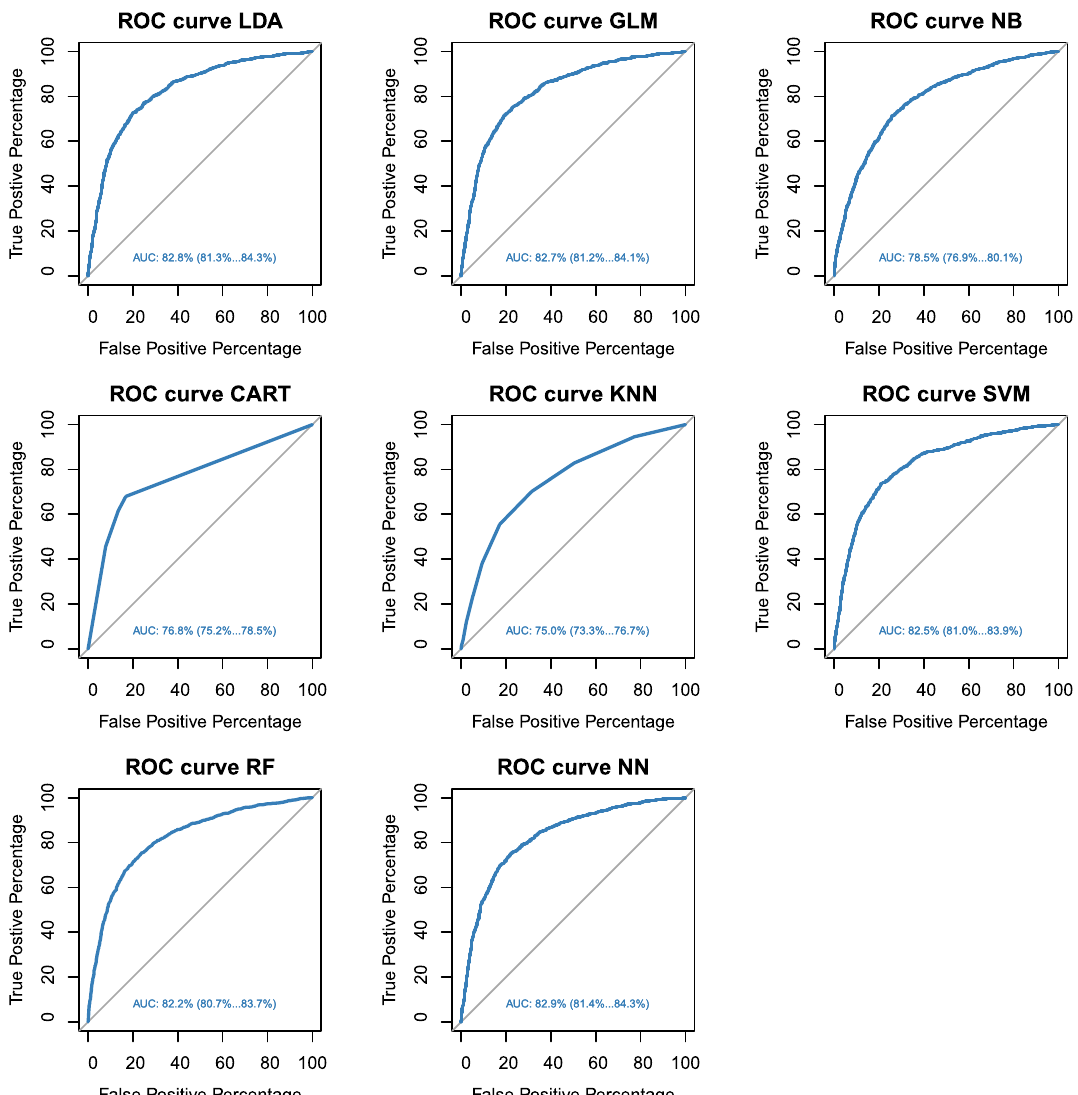
Figure 5. Comparing Receiver Operating Characteristic (ROC) curves of eight machine learning methods [Linear Discriminant Analysis (LDA), Generalized Linear Model (GLM) with logit link function, Naïve Bayes (NB), Classification and Regression Trees (CART), k-Nearest Neighbors (kNN), Support Vector Machines (SVM), Random Forest (RF) and Neural Network (NN)] run on the validation set, in prediction of udder health status of dairy cows according to somatic cell count below or above 200,000 cells/mL from cow’s and milk data recorded at the previous test-day record. In each plot, area under the curve (AUC) and 95% confidence interval were